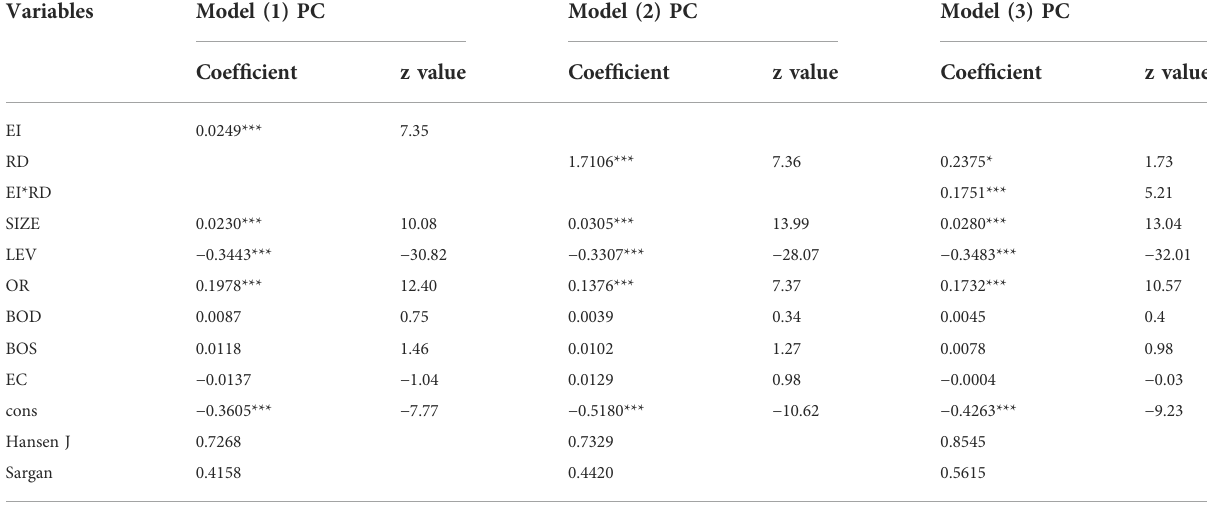
TABLE 10 Robustness test of the regression results of